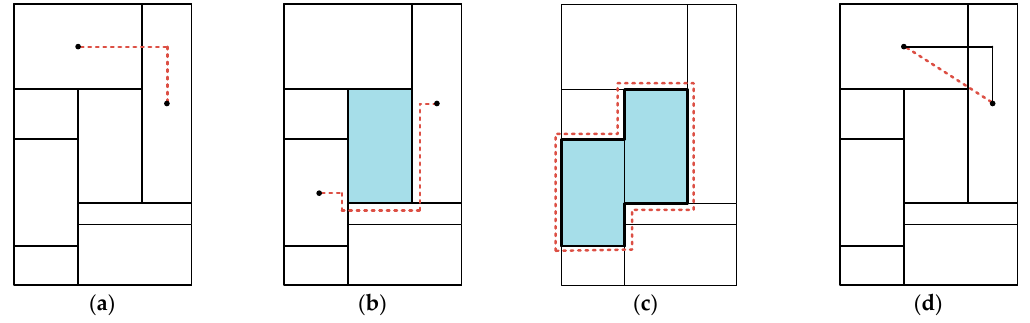
Figure 1. Examples of distance measurement. ( a ) Rectilinear distance; ( b ) Contour distance; ( c ) Single loop distance; ( d) Euclidean distance.